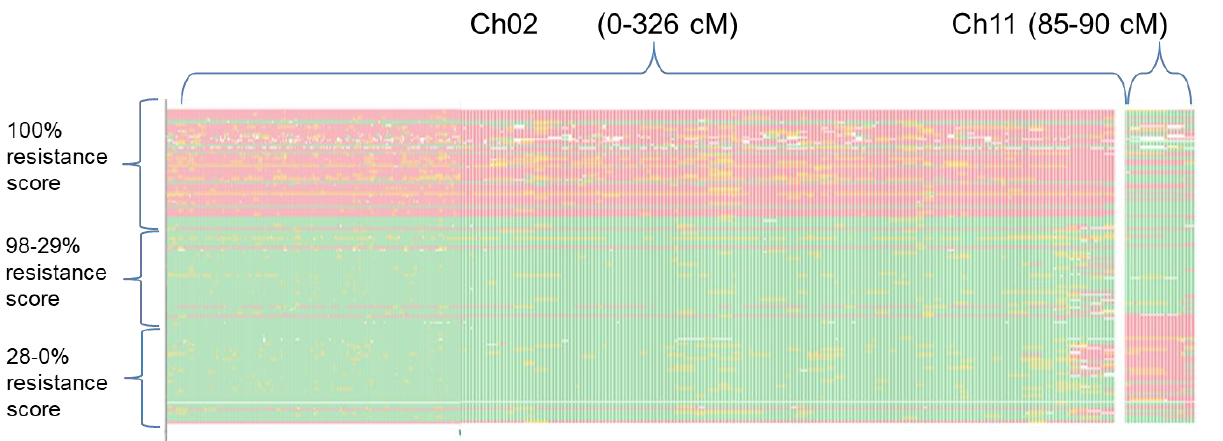
Figure 4. Haplotype distribution in the RIL population of all GBS markers mapped on CH02 (0 – 326 cM) and CH11 (85 – 90 cM) was ordered according to their resistance scores (on the left panel, descending from 100% to 0). Each line represents RIL progeny. In red, haplotype of ‘305E40’ ; in green haplotype of ‘67/3’ ; in yellow heterozygous markers; in white, missing data.